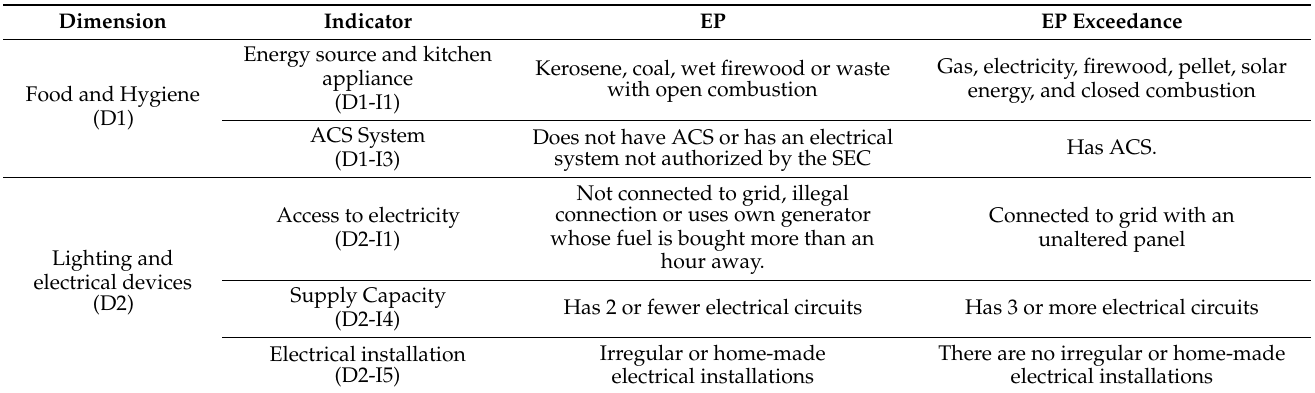
Table A8. Summary of dimensions and thresholds adapted for